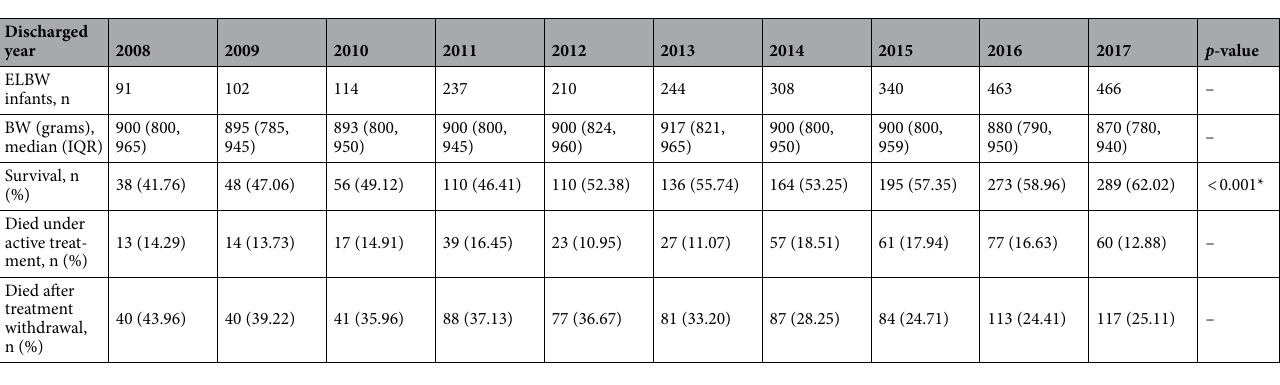
Table 2. The survival rate of extremely low birth weight (ELBW) infants at discharge from 2008 to 2017. *Chi- square test linear-by-linear association. ELBW: Extremely low birth weight; IQR: Interquartile range.